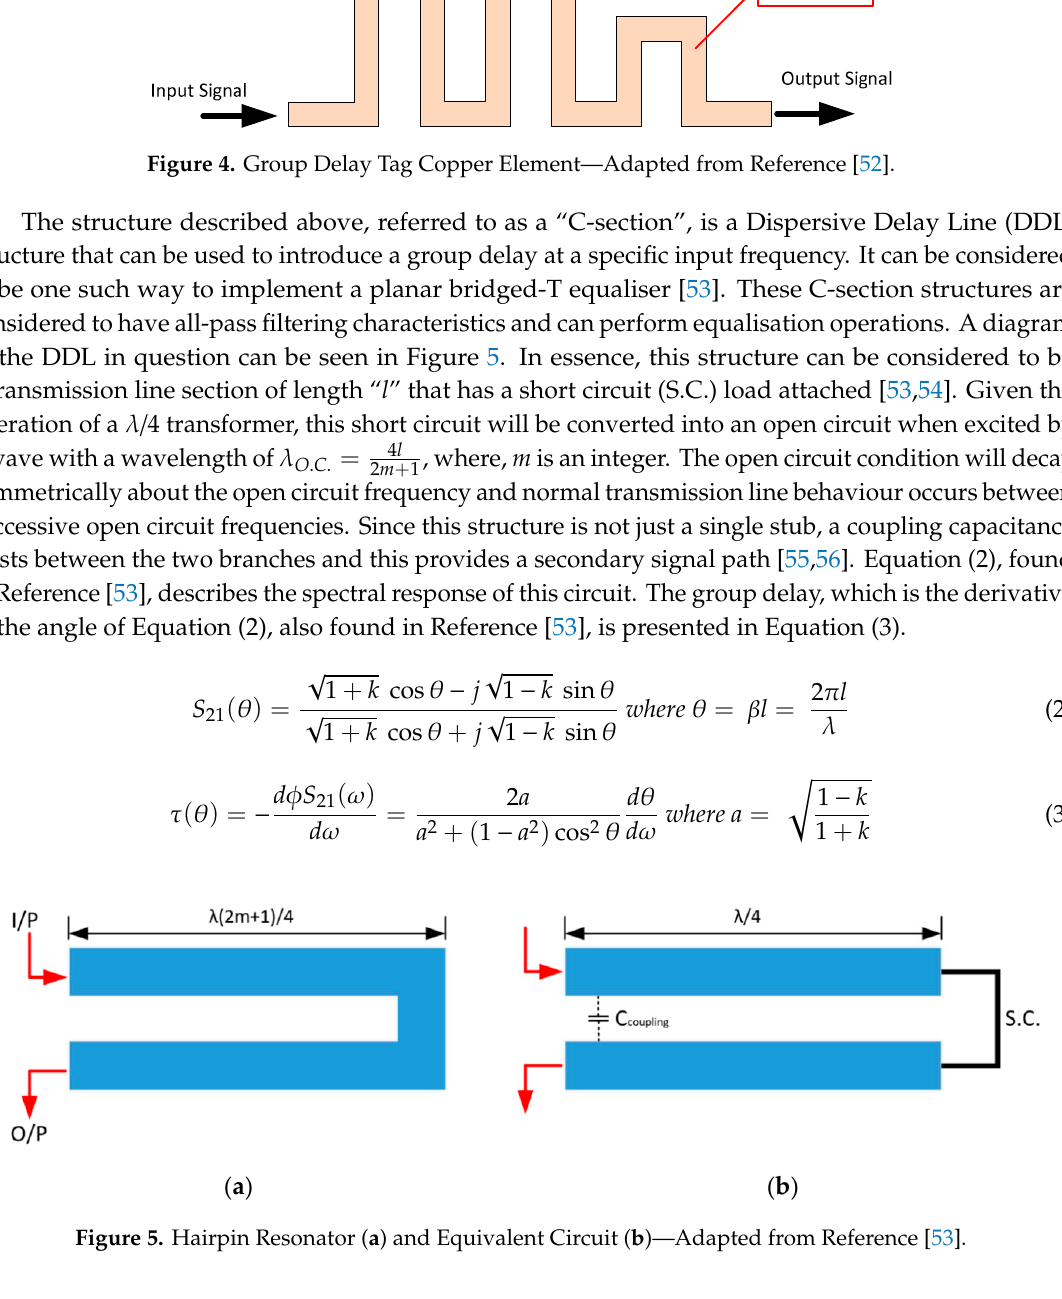
Figure 5. Hairpin Resonator ( a ) and Equivalent Circuit ( b )—Adapted from Reference [53]